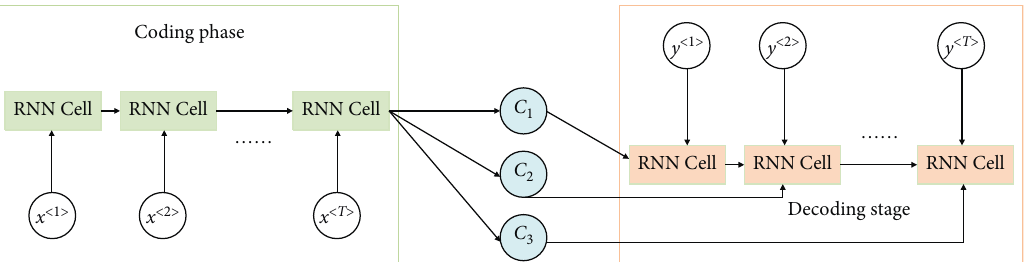
Figure 5: Structure of the attention model.